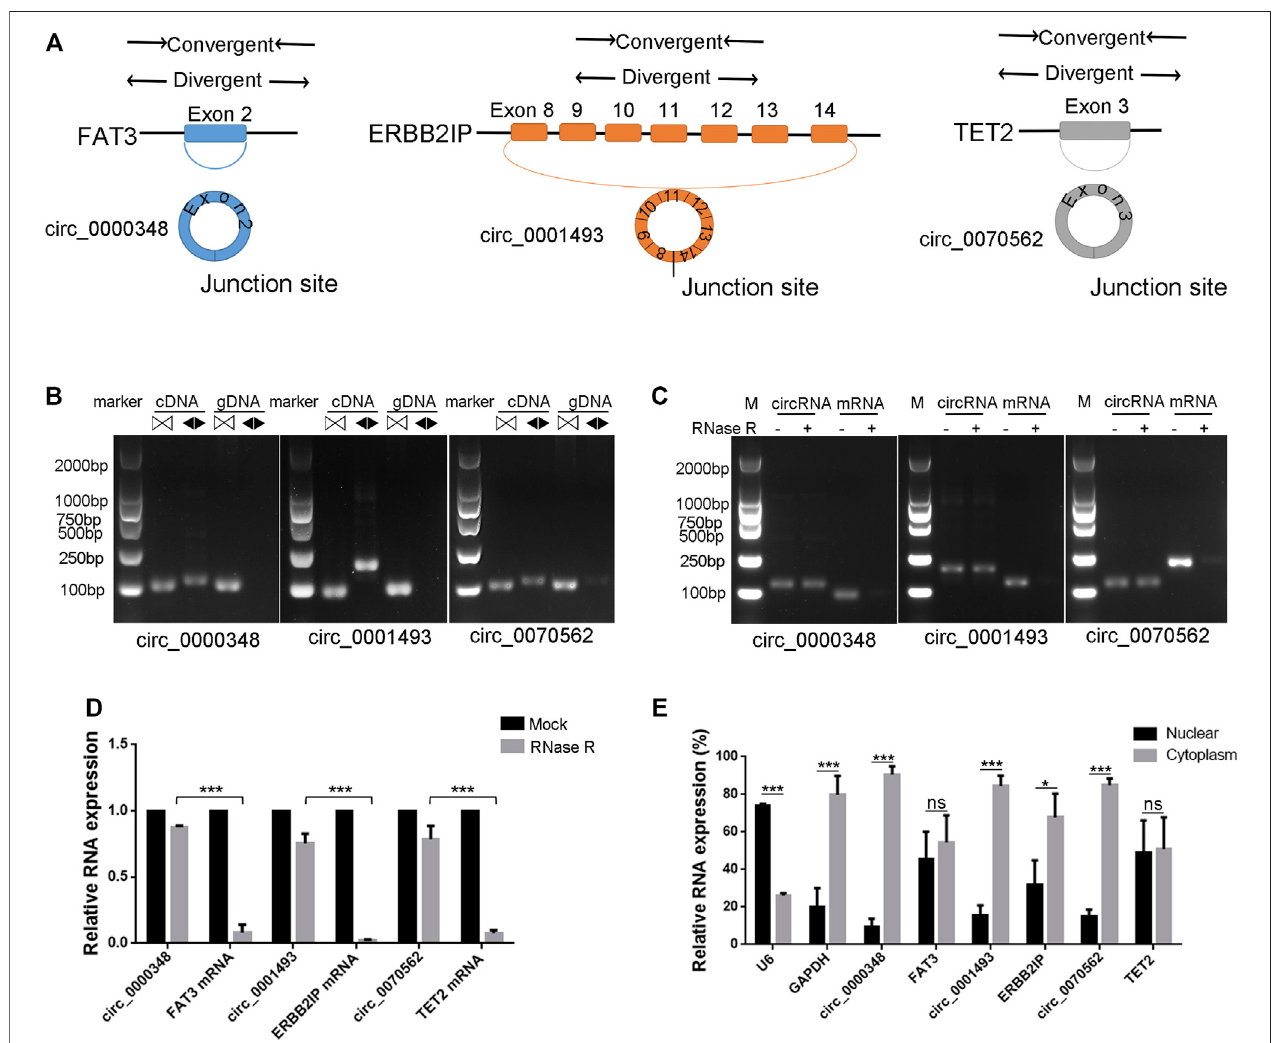
FIGURE 7 | Characterization of hsa_circ_0000348, hsa_circ_0001493 and hsa_circ_0070562 in BMSCs. (A) . Schematic illustration showing FAT3 exon two circularisation to form circ_0000348, ERBB2IP exons 8 – 14 circularisation to form circ_0001493, TET2 exon three circularisation to form circ_0070562. (B) . The presenceofcirc_0000348,circ_0001493andcirc_0070562werevalidatedinBMSCsbyRT-PCR.Divergentprimers( =< )ampli fi edcircRNAsfromcDNA,butnotfrom genomic 7) DNA. 89 indicates convergent primer. (C) . The DNA electrophoresis results of RT-PCR of circ_0000348 and FAT3 mRNA, circ_0001493 and ERBB2IP mRNA, circ_0070562 and TET2 mRNAs in BMSCs treated with or without RNase R. (D) . The decrease degree of circRNAs was signi fi cantly less than that of their parental genes after RNase R treatment. n = 3 BMSCs samples. (E) . Nuclear and cytoplasmic RNAs extraction and qPCR detection revealed circ_0000348, circ_0001493andcirc_0070562wereexpressedmainlyinthecytoplasm.U6wasusedasaninternalcontrolfornuclearRNA,whereasGAPDHservedasthecontrolfor cytoplasmic RNA. n = 3 BMSCs samples. Data are presented as the means ± SEM. * p < 0.05. *** p < 0.001. ns: not signi fi cant.